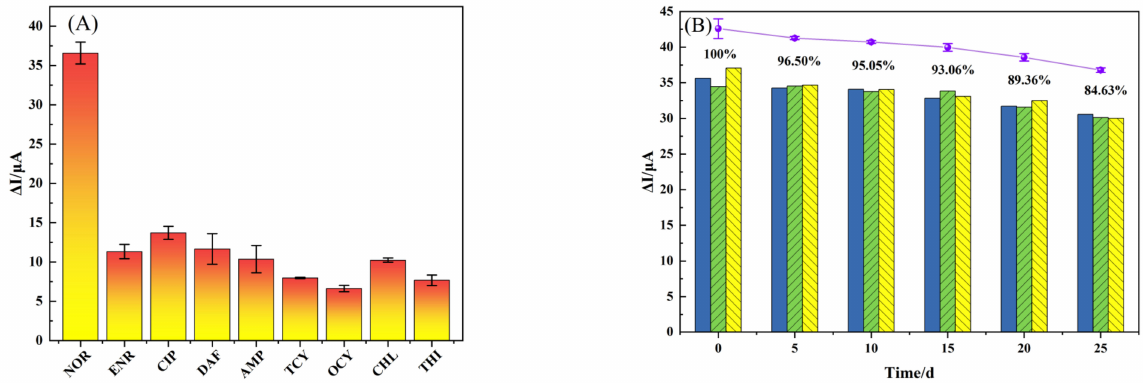
Figure 10. ( A ) the selectivity and ( B ) stability of MIP/TBC/GCE